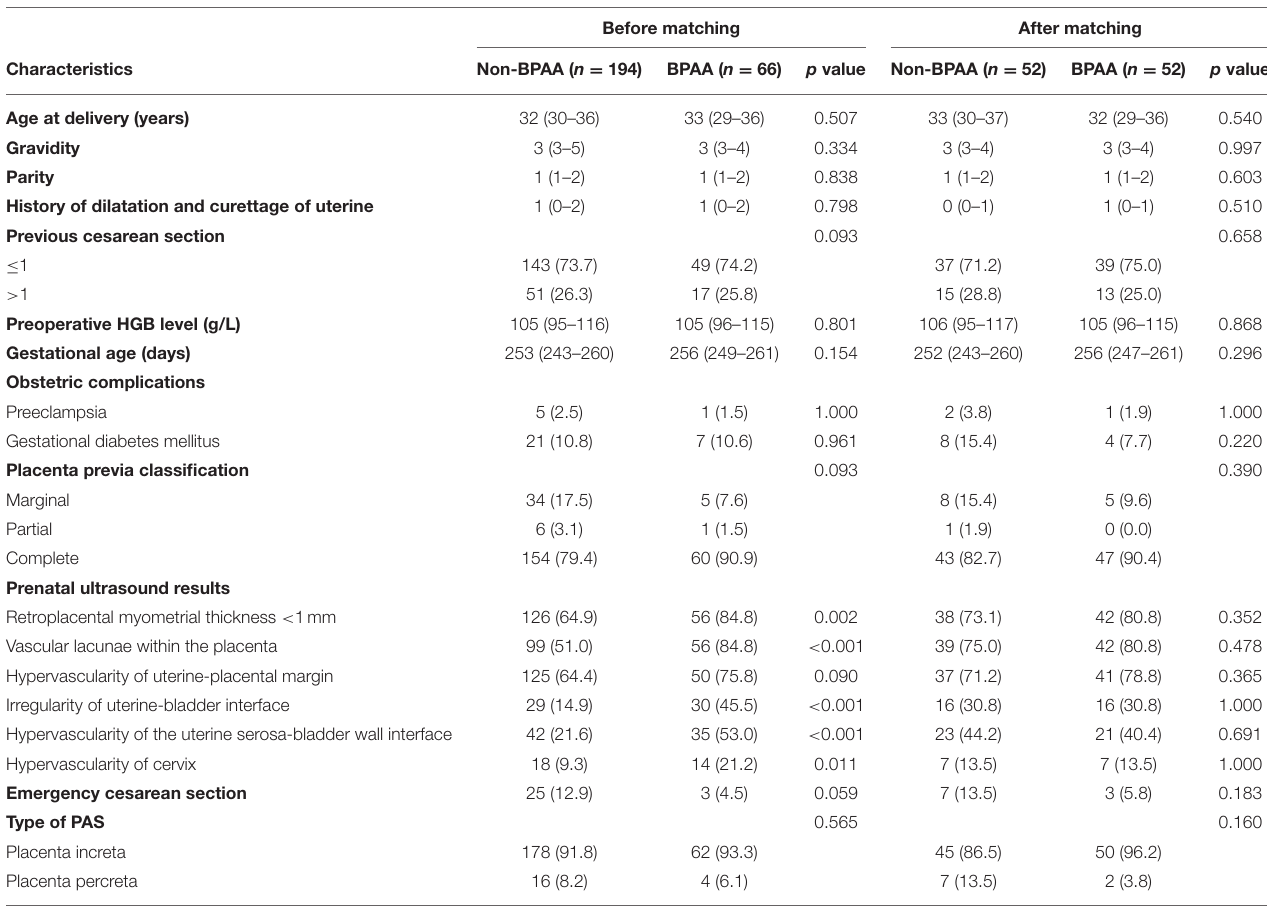
TABLE 1 | Characteristics before and after propensity score